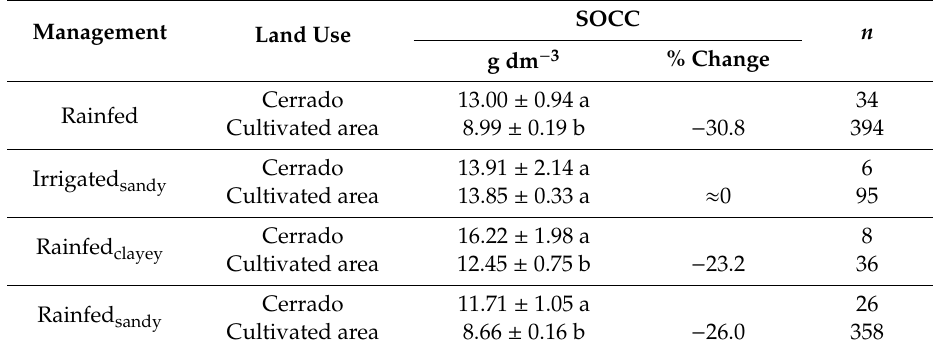
Table 5. Comparison of soil organic carbon content (SOCC) in the 0.00–0.20 m layer in areas of native Cerrado and in areas cultivated for more than 20 years under di ff erent management practices and with di ff erent soil particle